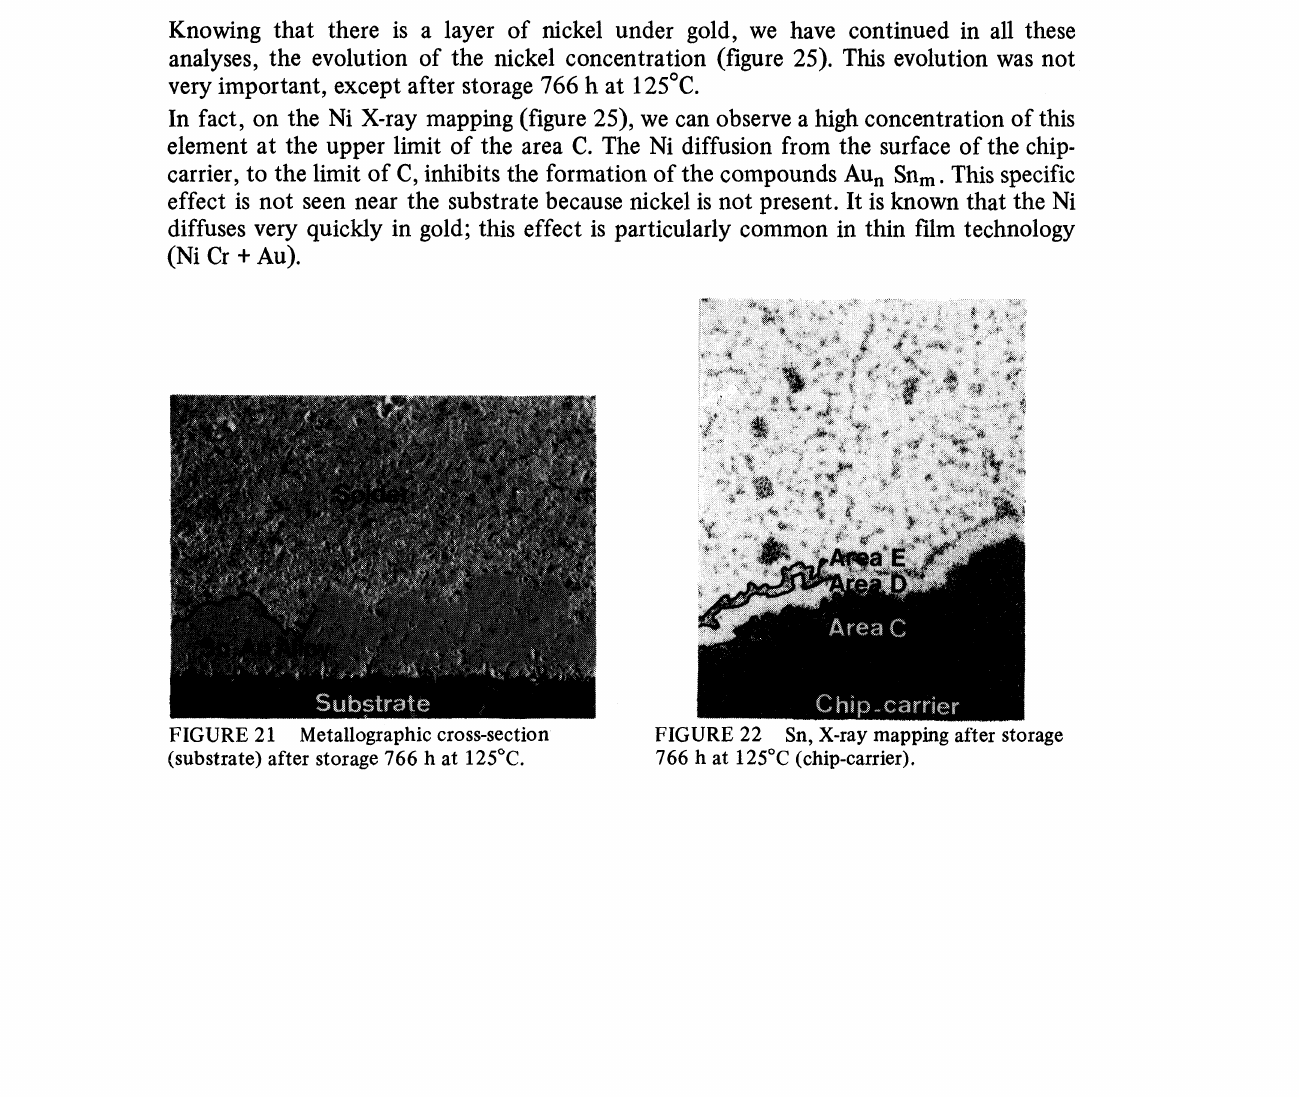
FIGURE 20 Au, X-ray mapping after storage 766 h at 125C (substrate).